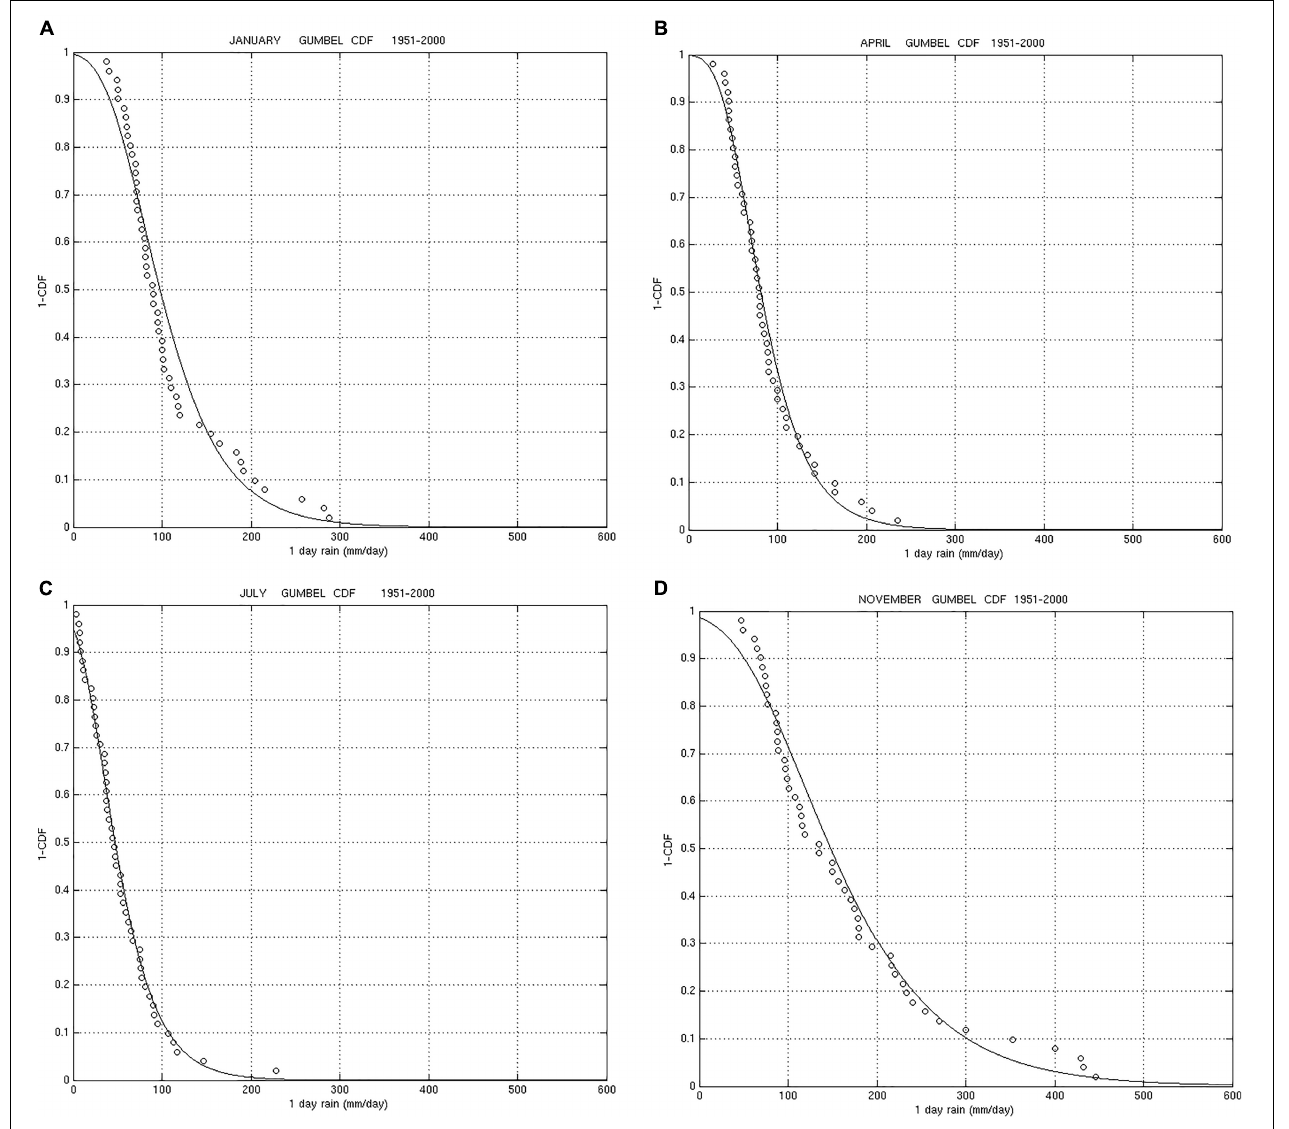
FIGURE 5 | (A–D) Empirical and Gumbel CDF for January, April, July, and